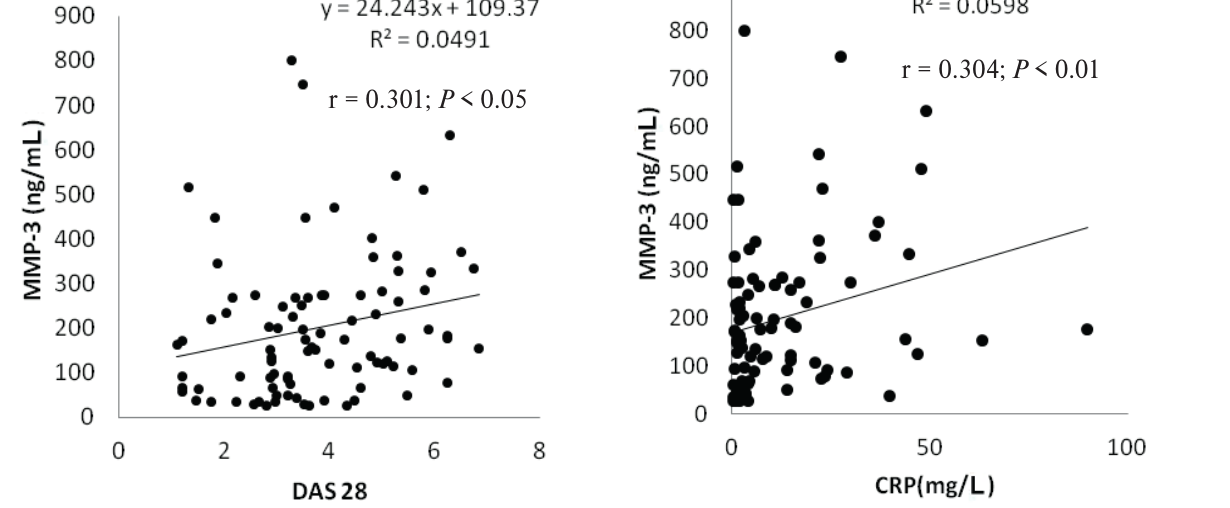
Fig. 4. Correlation between MMP-3 and